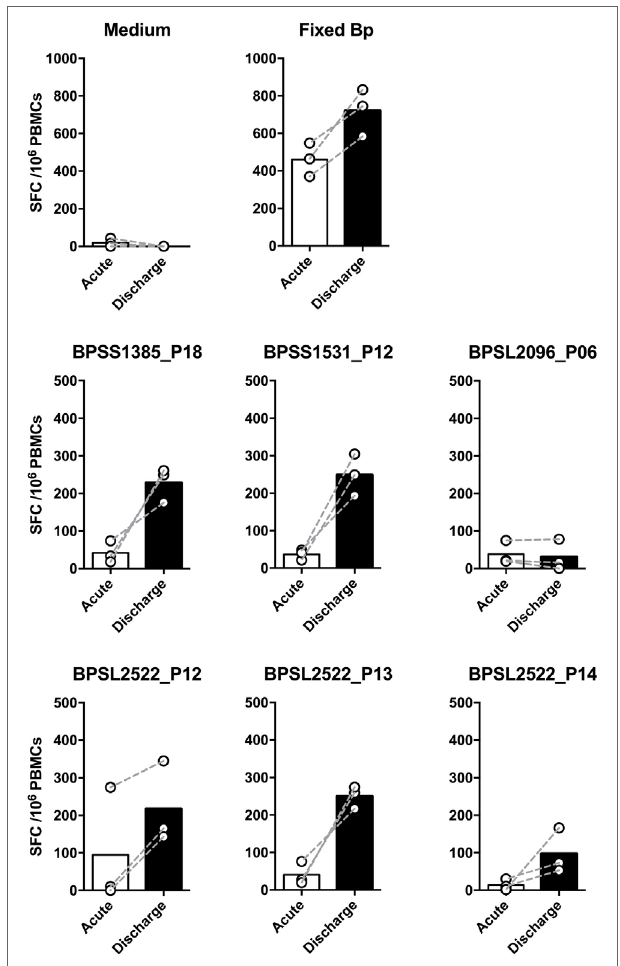
FigUre 4 | Comparison of IFN γ responses to top six T-cell immunoprevalent peptides of Burkholderia pseudomallei (Bp) in patients with a diagnosis of acute melioidosis at the time of acute admission and following recovery having completed antibiotic treatment. Peripheral mononuclear cells (PBMCs) from patients diagnosed with acute melioidosis were cultured with medium only control, paraformaldehyde (PFA) fixed Bp, or T-cell immunoprevalent peptides for 48 h. IFN γ induction was quantified by ELISpot. The results show the comparison of individual IFN γ responses between samples taken on admission (acute, white bar) and discharge (day 30, black bar) from the same patients ( n = 3). The differences were not statistically significant using Wilcoxon matched-pairs signed rank test.